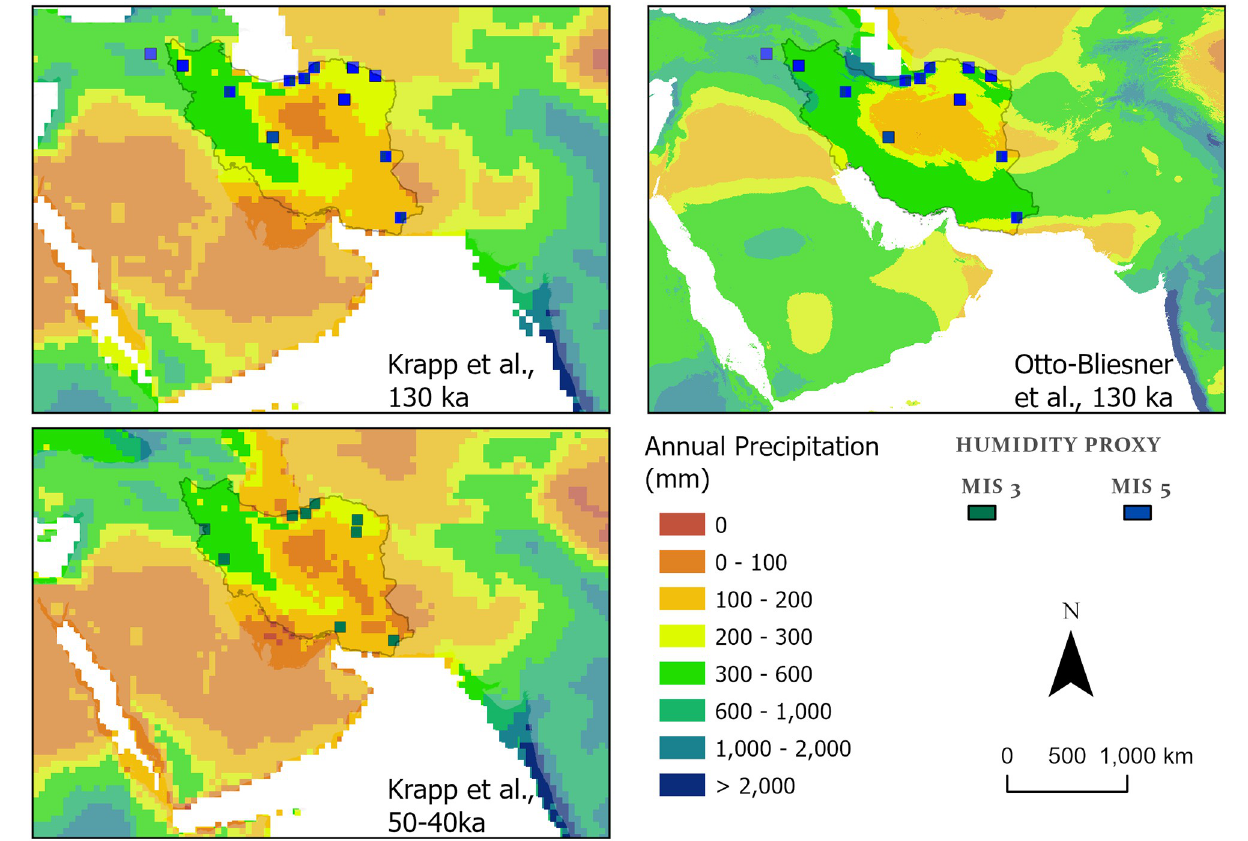
Fig 7. Annual precipitation estimates from paleoclimate models for MIS 5e (~130 ka Krapp et al. [61], and ~130 ka Otto-Bliesner et al. [60]), and MIS 3, overlain with broadly contemporaneous proxy sites. MIS 3 data is from the Krapp et al. [61] model and displays the mean value during the broad window of 50–40 ka when age depth modelling of northern Iranian loess (Fig 4) suggests phases of enhanced humidity. Map created by one of our authors (PSB).